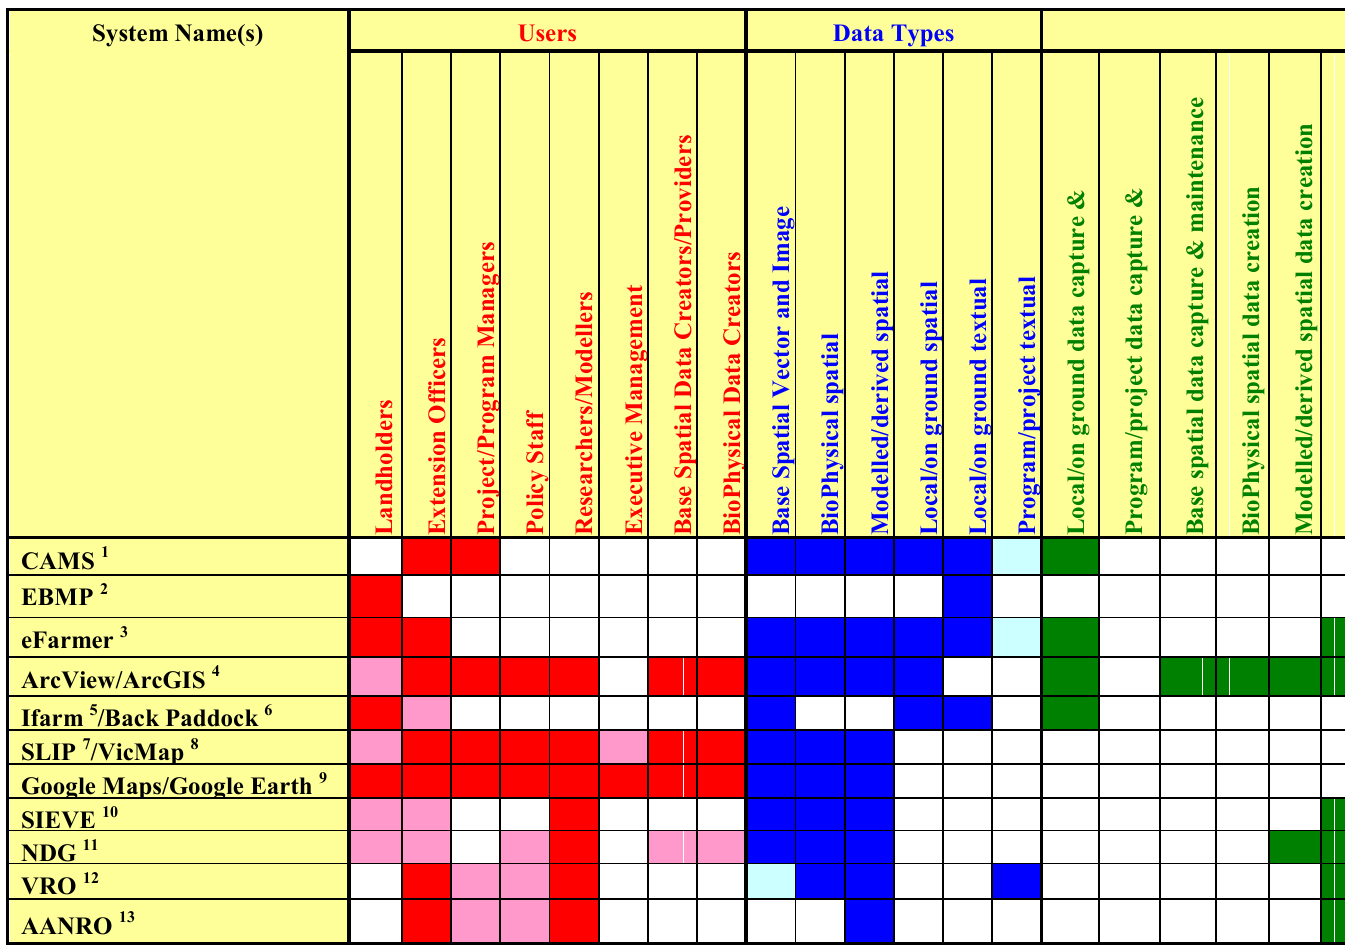
Table 1. Assessment of functionality of existing systems complementary to the EASY